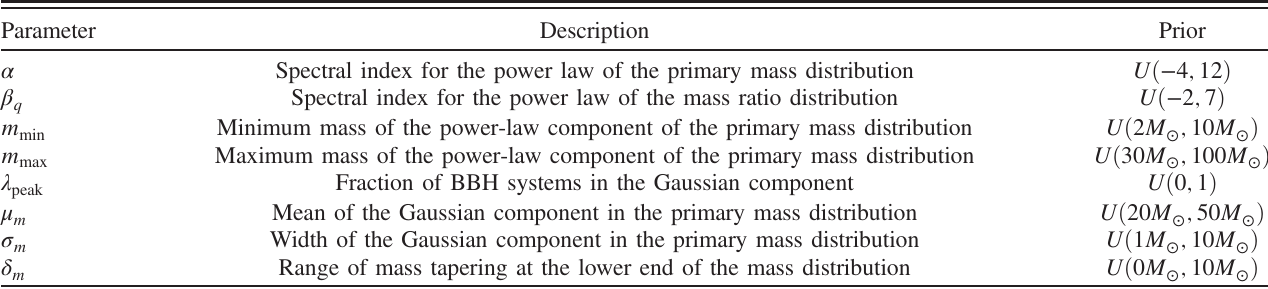
TABLE VI. Summary of P OWER L AW +P EAK model parameters. Parameter